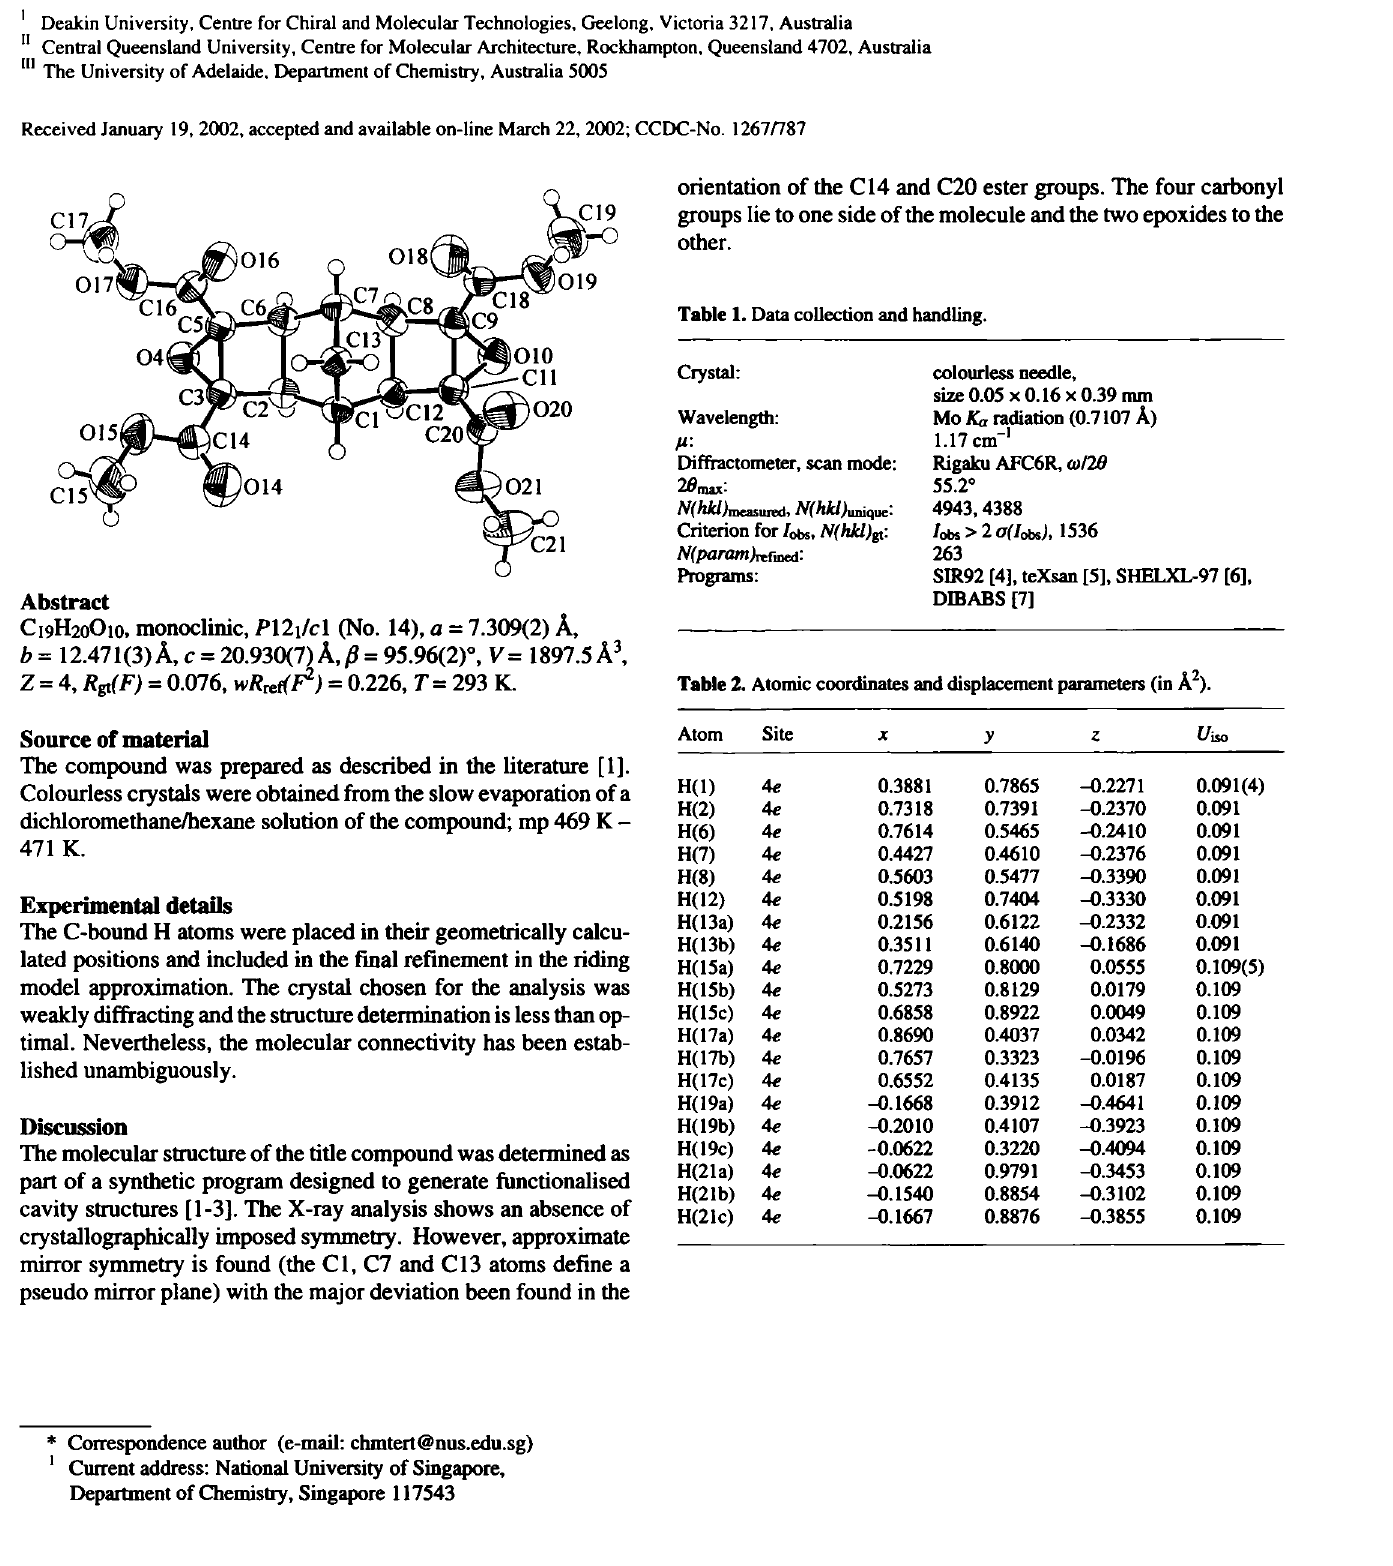
Table 1. Data collection and handling.